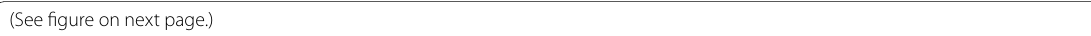
(See figure on next Fig. 1 Website https:// www. hebel oma. org. a Segment of the species page of Hebeloma crustuliniforme . ( b – e ) expanded contents of selected headings. b Thresholds (partial contents), explaining the numerical meaning of terms used in machine generated species descriptions. Column header “Min. value” is short for minimum proportion of collections of the respective species having the feature. c Microscopic description and d Statistics of spore and cheilocystidia measurements. For H. crustuliniforme , the description is based on 106 collections. e Image gallery (partial) of basidiome photos of H. crustuliniforme